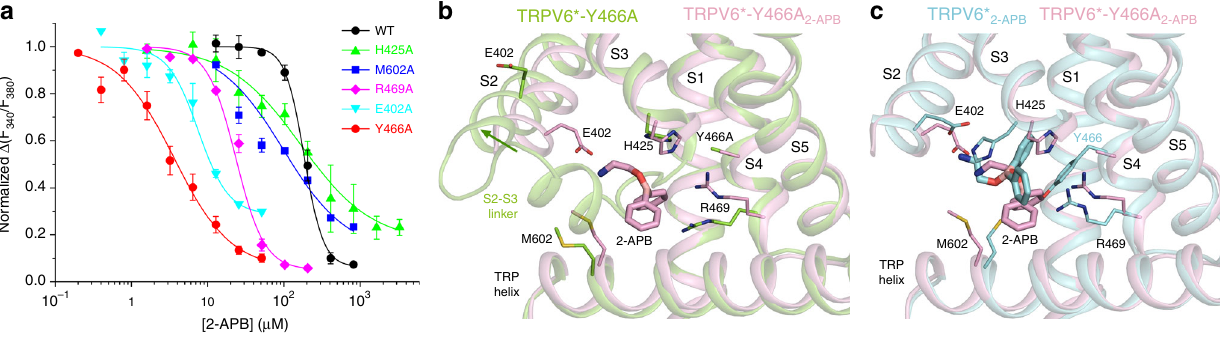
Fig. 4 Probing of 2-APB binding site in TRPV6 by mutagenesis. a Dose – response curves for 2-APB inhibition of wild-type and mutant rat TRPV6 channels with residues in the 2-APB binding pocket individually substituted to alanine. Error bars represent SEMs ( n = 3 – 7). b Close-up view of superposition of the 2-APB binding pocket in the TRPV6*-Y466A (green) and TRPV6*-Y466A 2-APB (pink) crystal structures with the 2-APB molecule and surrounding residues shown as sticks. Green arrow indicates displacement of S2 in the absence of 2-APB, accompanied by increased order in the S2 – S3 linker. c Close-up view of superposition of the 2-APB binding pocket in the TRPV6* 2-APB (cyan) and TRPV6*-Y466A 2-APB (pink) crystal structures